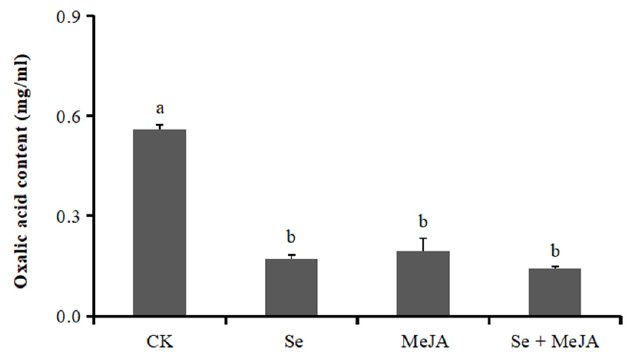
Figure 6. Effect of Se, MeJA and Se + MeJA on mycelium oxalic acid content of Botrytis cinerea (n = 4). CK: Control group; Se: 5.0 mg/L Se; MeJA: 0.4 mM MeJA; Se + MeJA: 5.0 mg/L Se with 0.4 mM MeJA. Vertical bars indicate standard error. Values with the same letter are not significantly different at p < 0.05 according to Duncan’s multiple range test.